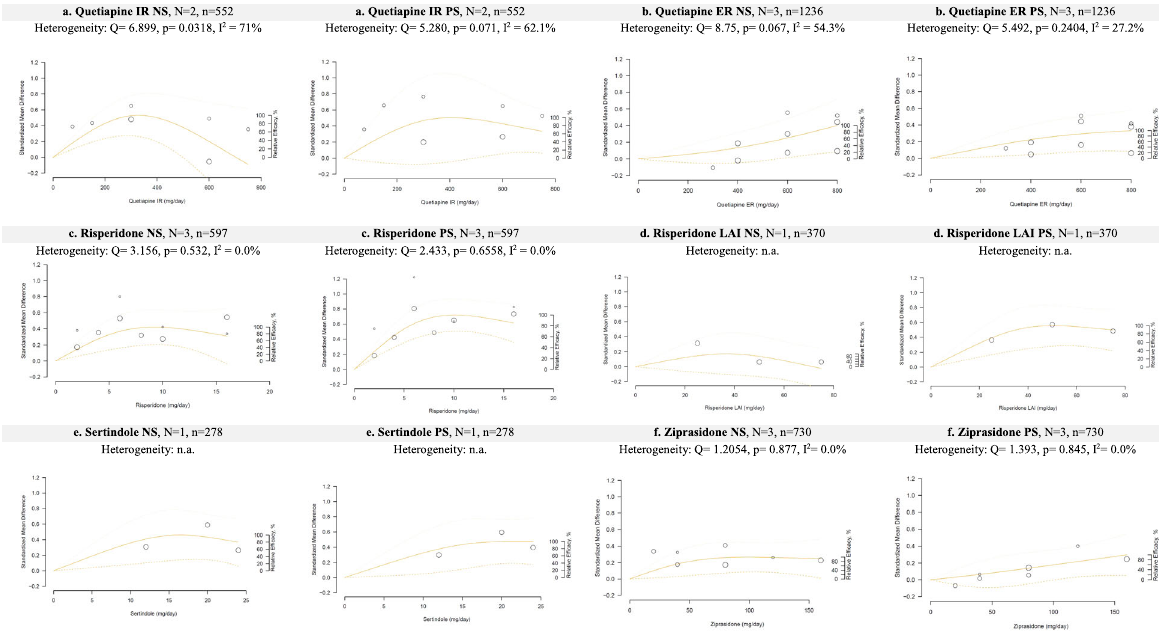
Fig. 3 Dose-response curves for quetiapine, risperidone, sertindole and ziprasidone regarding negative symptoms (NS) or positive symptoms